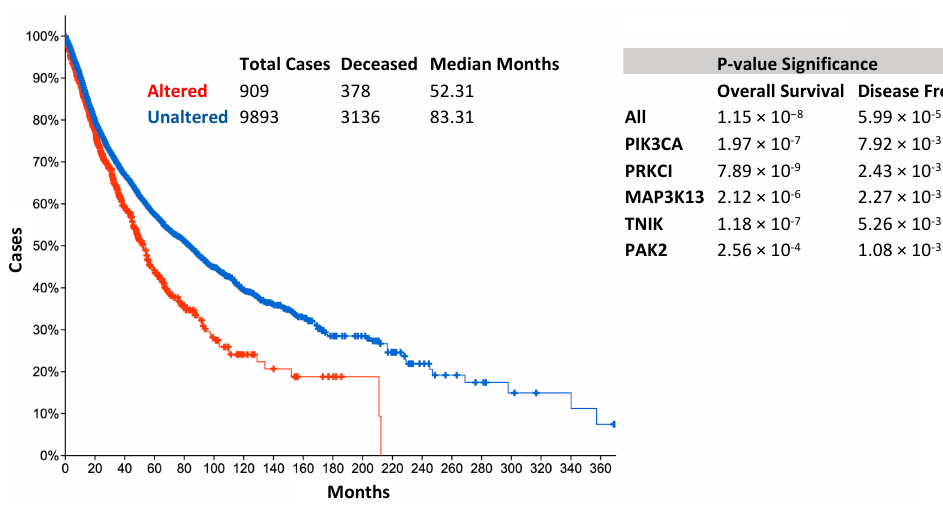
Figure 3. Survival statistics and amplification of 3q amplicon genes.